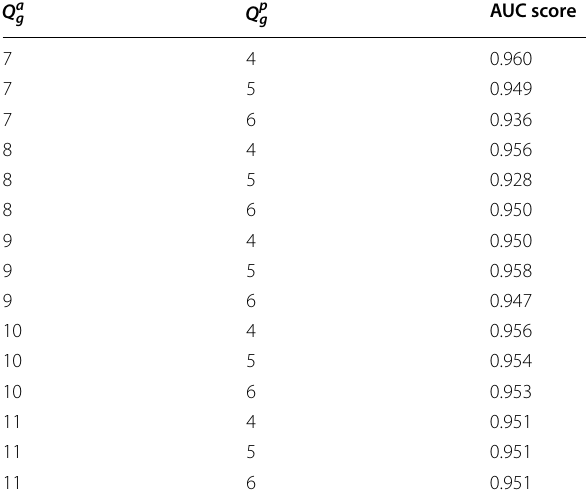
) with total quantization from 3